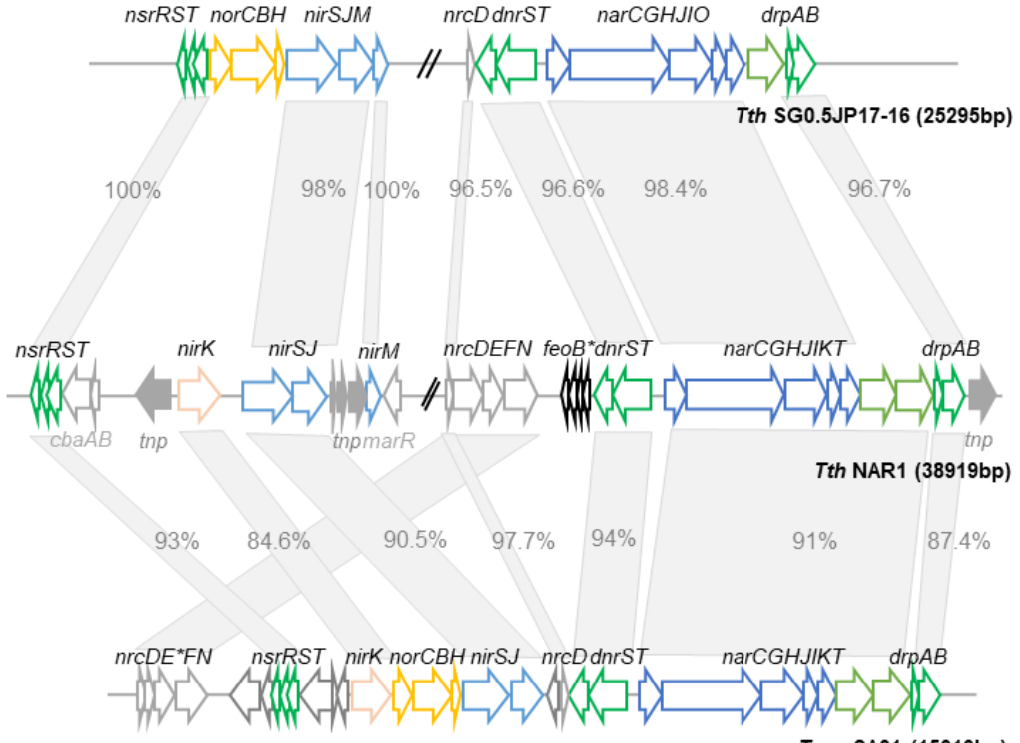
Figure 3. Comparison of the denitrification clusters of TthNAR1 and other Thermus spp. Genetic context of nitrate and nitrite respiration genes found in TthNAR1 , showing homolog genes and its order in the closely related strains TthSG05 JP17-16 and T. scotoductus SA-01 ( Tsco SA01). Genetic maps were performed according to fully assembled genomes available at NCBI database. Grey empty arrows represent genes not related with nitrate / nitrite respiration. Filled grey arrows represent transposases or fragments of transposases (indicated as tnp ). Genes anchored with an asterisk indicate truncated sequences (pseudogenes). Percentages of identities are indicated within the grey boxes and length of the arrows is proportional to the size of the CDS.